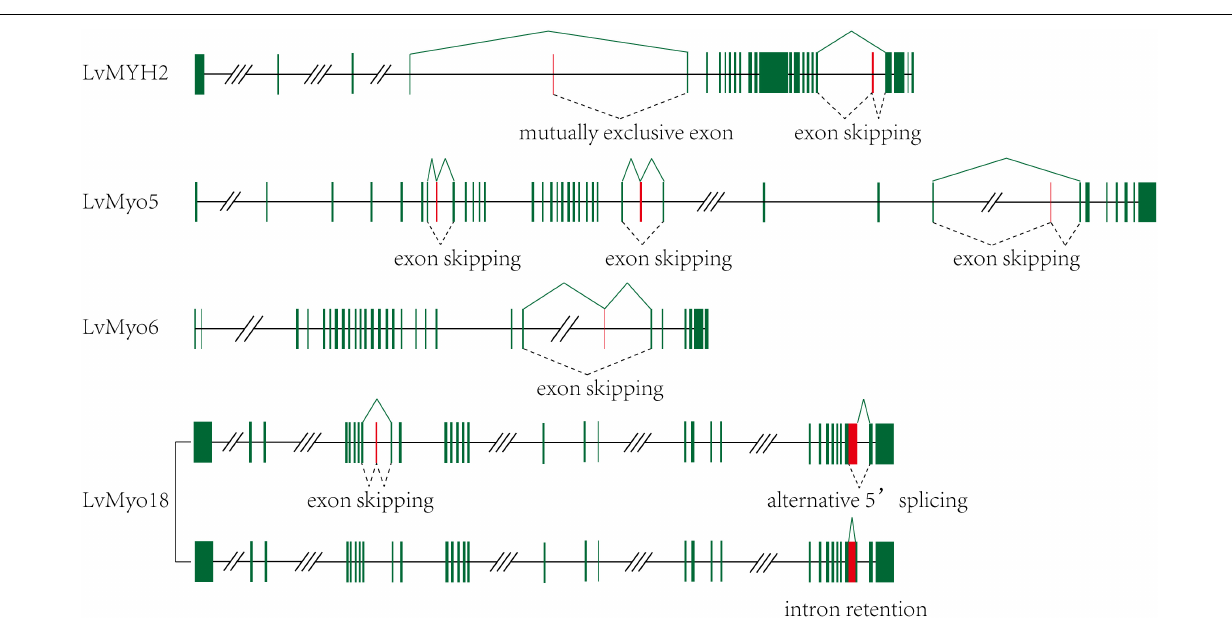
FIGURE 5 | Transcript evidences and splicing patterns for unconventional myosin genes in L. vannamei . Green boxes: exons; red boxes: alternative splicing exons; line, introns. Three-slashes represent large intron, and two-slashes represent genomic